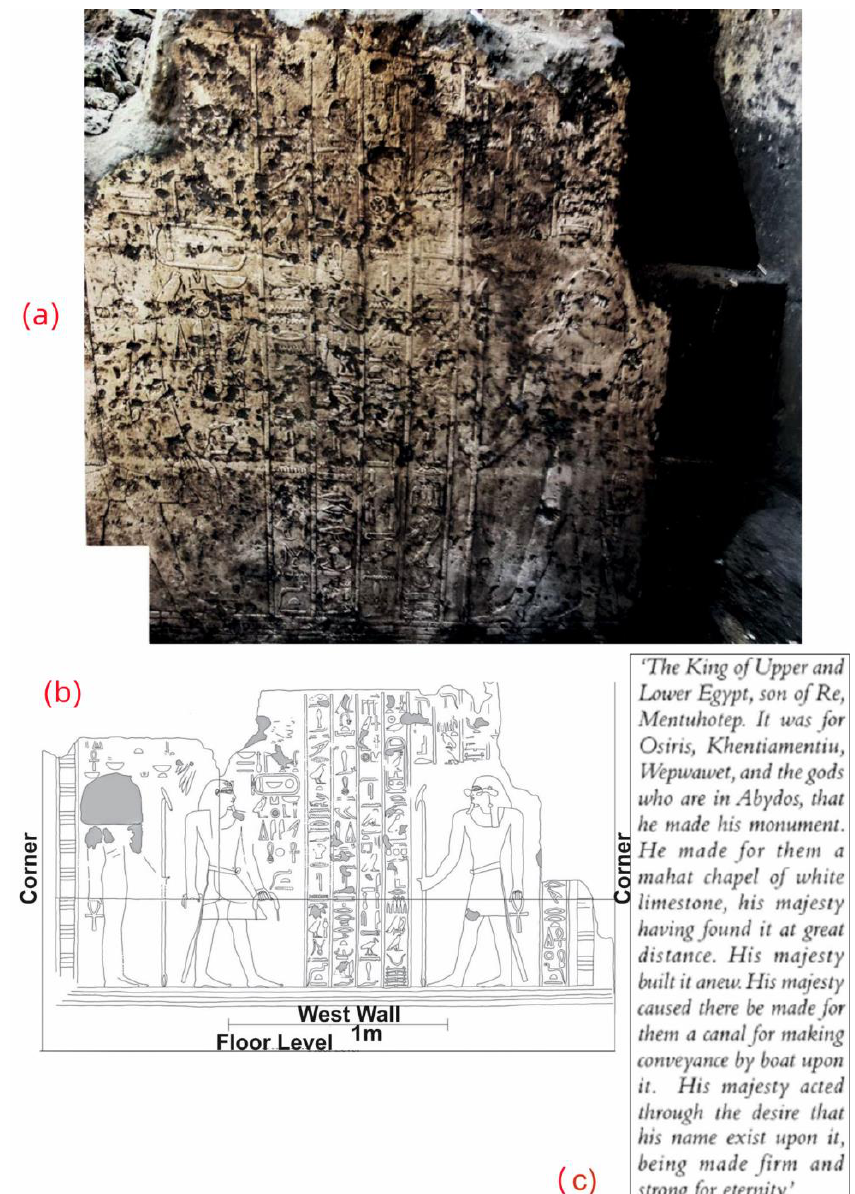
Figure 4. ( a ) A picture of the wall after excavation, showing Menit, often regarded as “ the mooring post, ” on the left and Neshmet, on the right; ( b ) The building’s ded ication text, which is written on the west wall. This picture was created in collaboration between Kevin Cahail and Jennifer